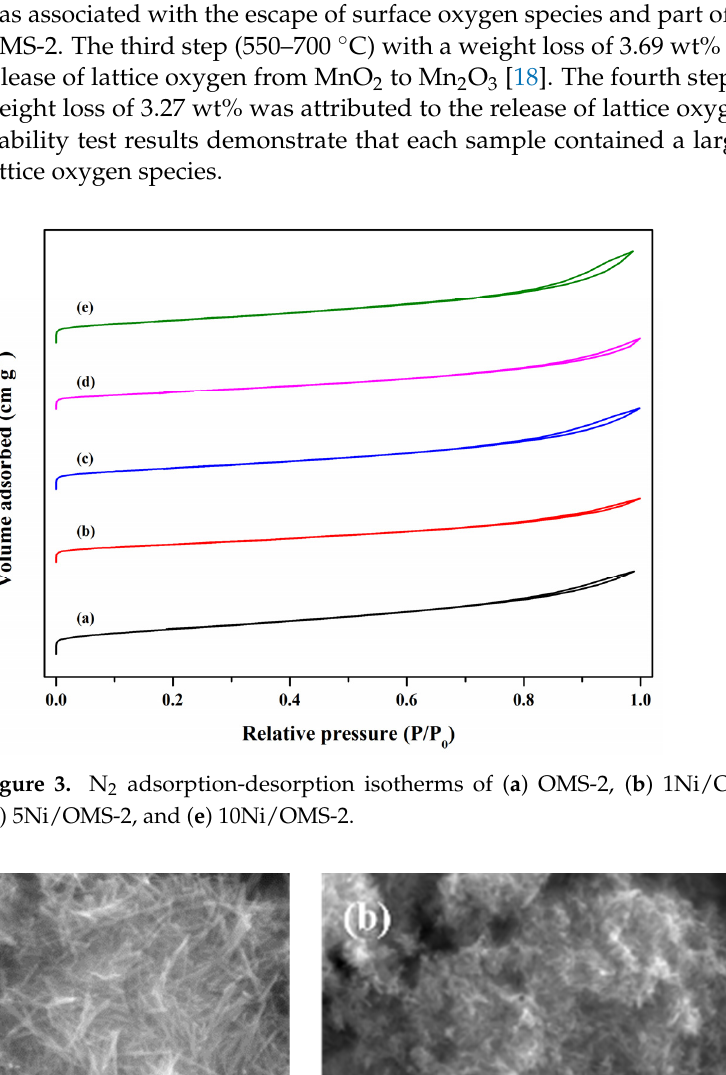
Figure 4. SEM images of ( a ) OMS-2 and ( b ) 5Ni/OMS-2.